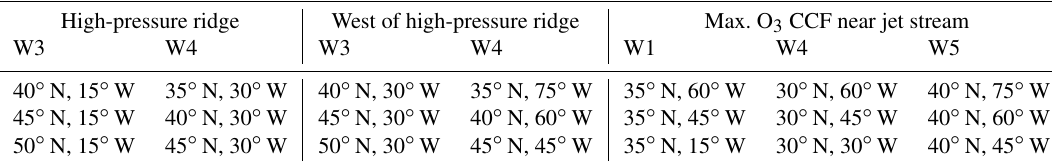
Table A1. Overview of all considered locations for the weighted probability density functions. High-pressure ridge West of high-pressure